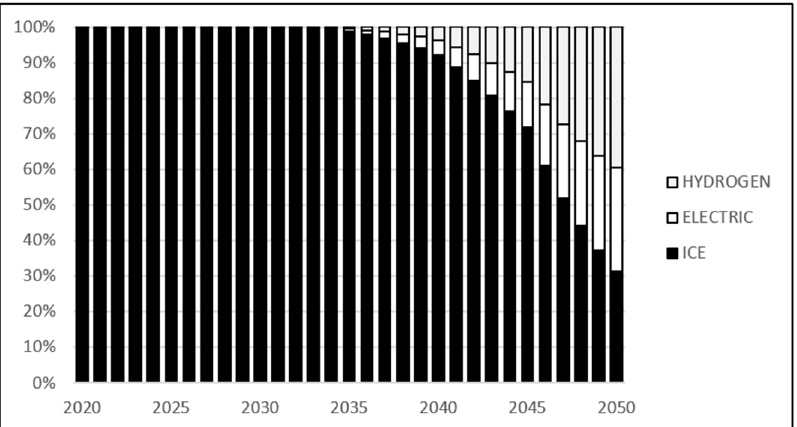
Figure 10. Structure of heavy duty vehicles (HDV’s) in Poland in the years 2020–2050 by engine type [NEU scenario]. Source: own calculations based on TR 3 E model results.